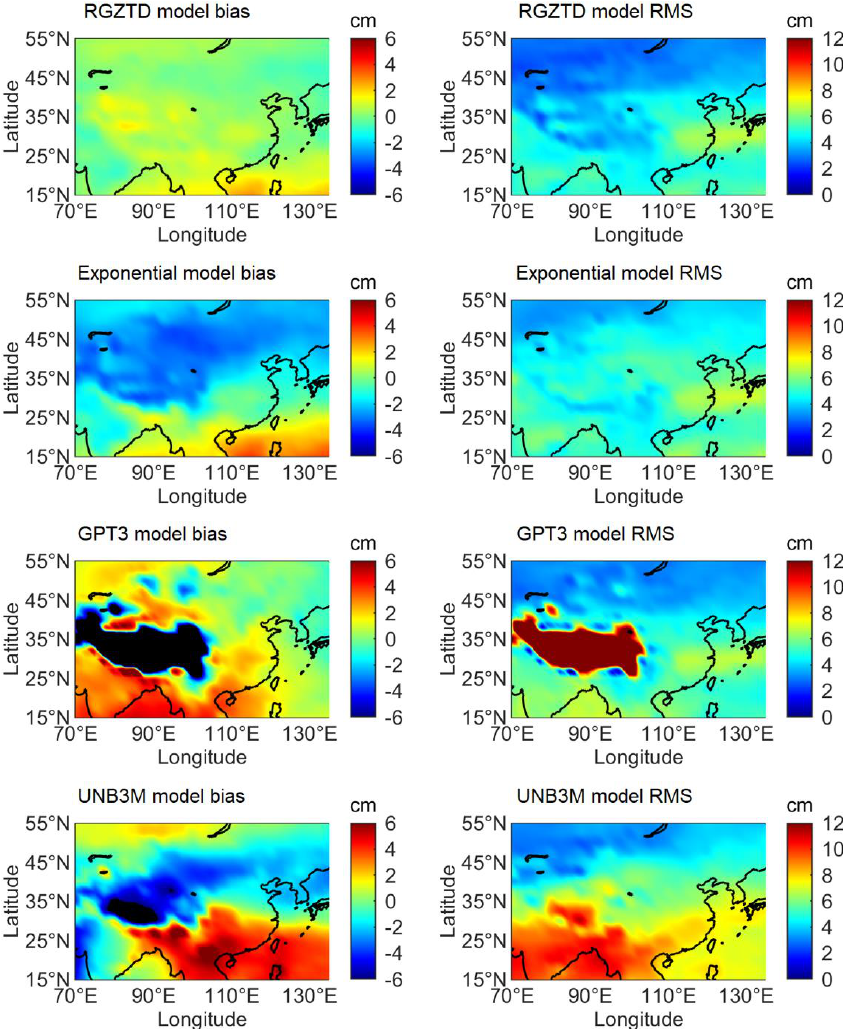
Figure 5. Distribution of bias and RMS of RGZTD model, Exponential model, GPT3 model and UNB3M model over China and the surrounding areas, where the ERA5 ZTD data is the reference value. Table 1. Mean bias and RMS of RGZTD model, Exponential model, GPT3 model and UNB3M model with respect to ERA5 ZTD data in 2017–2018 [cm].